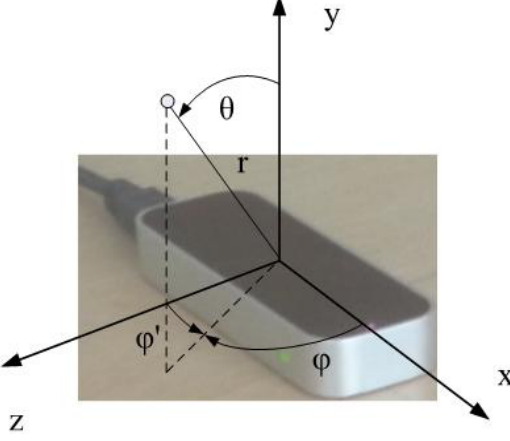
Figure 1. The Cartesian and spherical coordinate systems used to describe positions in the controller’s sensory